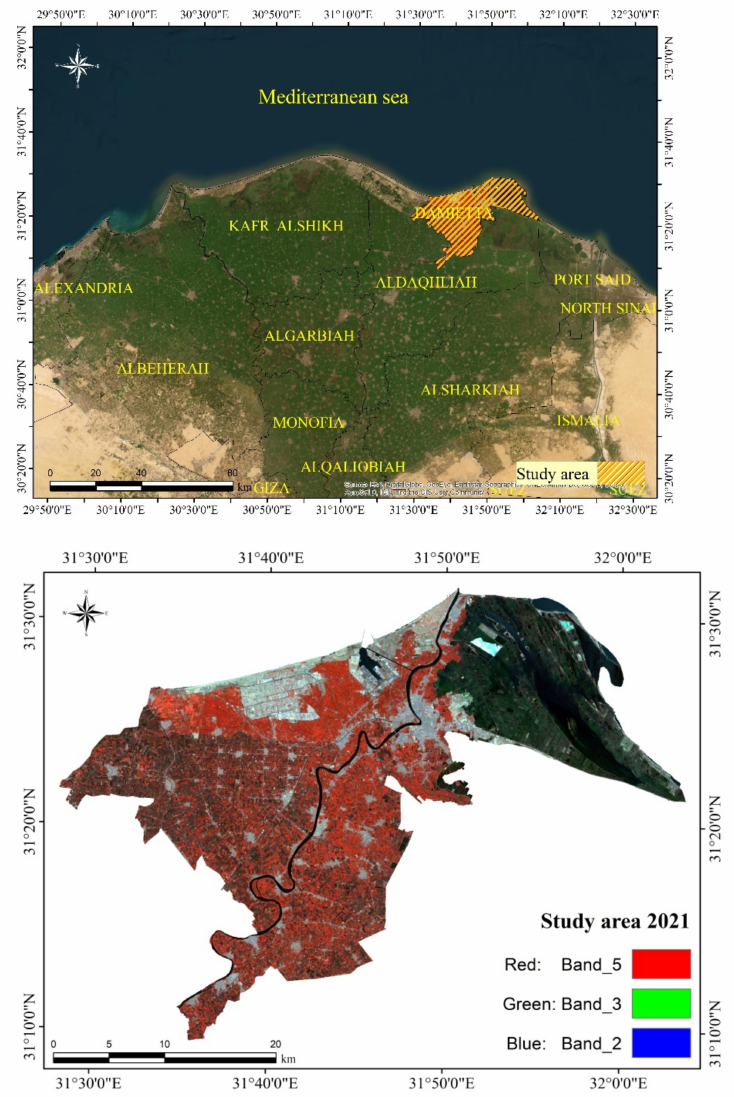
Figure 1. The location map showing Damietta